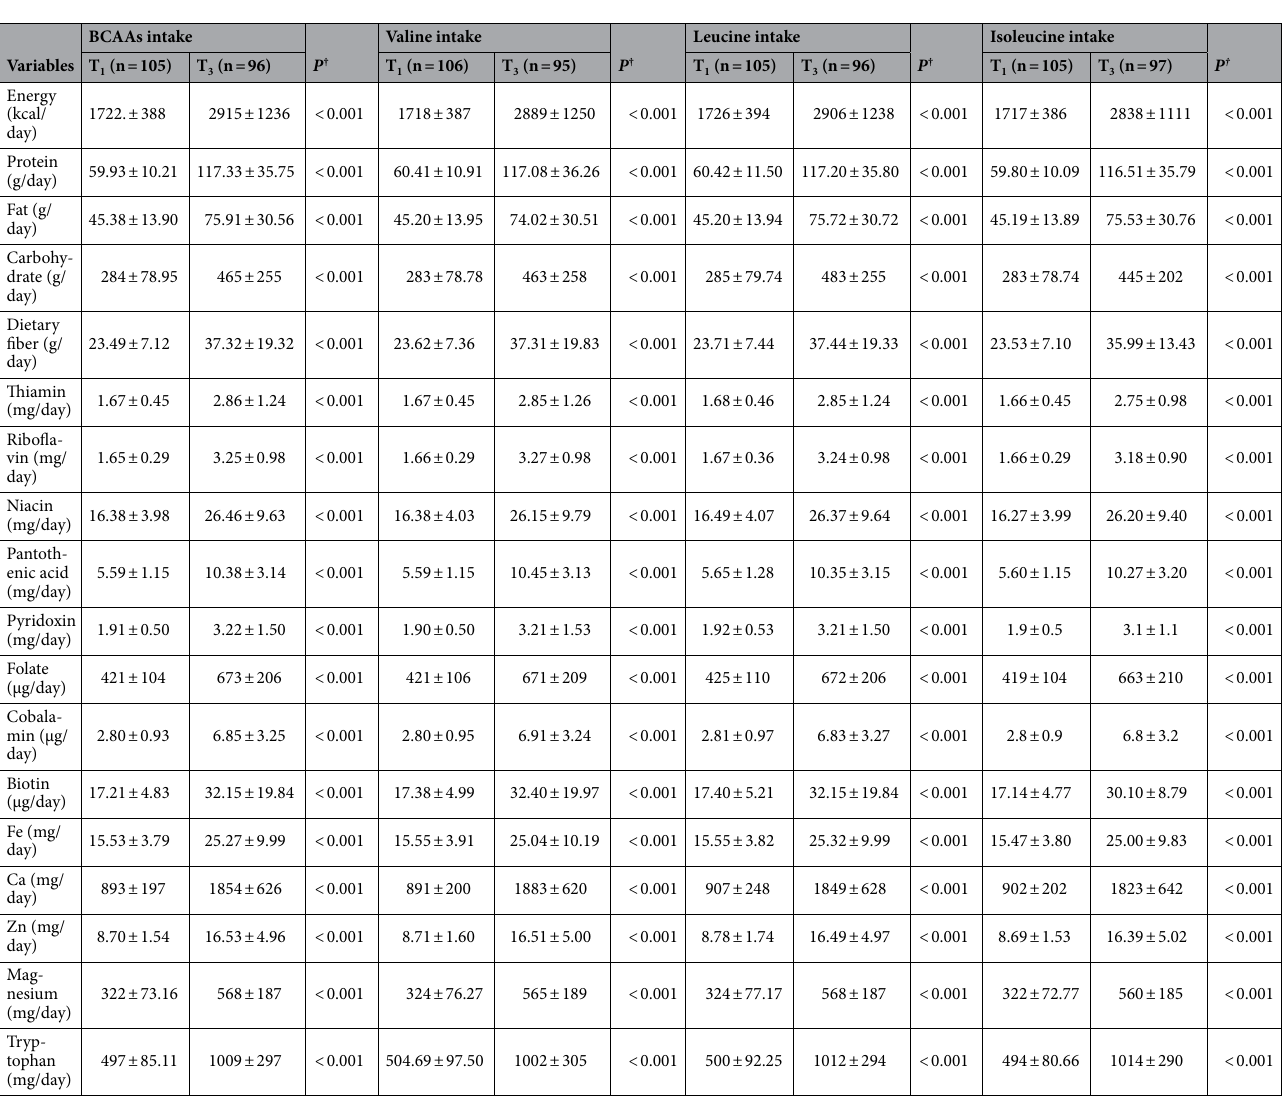
Table 4. Dietary intakes of study participants across categories of BCAAs, valine, leucine and isoleucine intake. All values are mean ± SD; † ANOVA for all